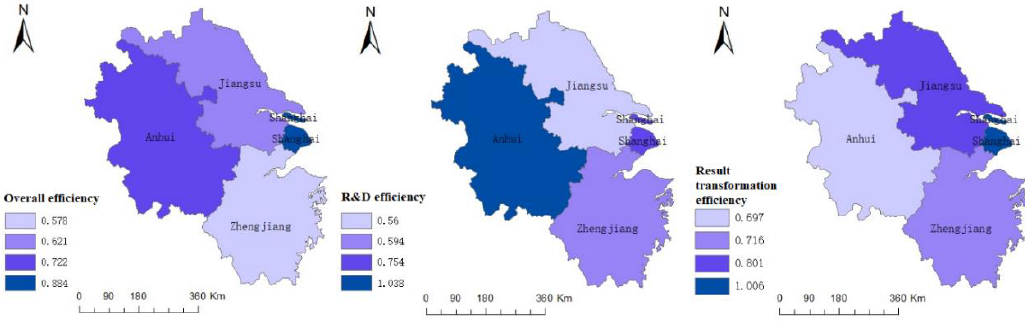
Figure 3. Spatial Distribution of Efficiencies in Each Stage. Table 6. Distribution of Overall Efficiency in high-tech Manufacturing Industry from 2010 to 2020. Time